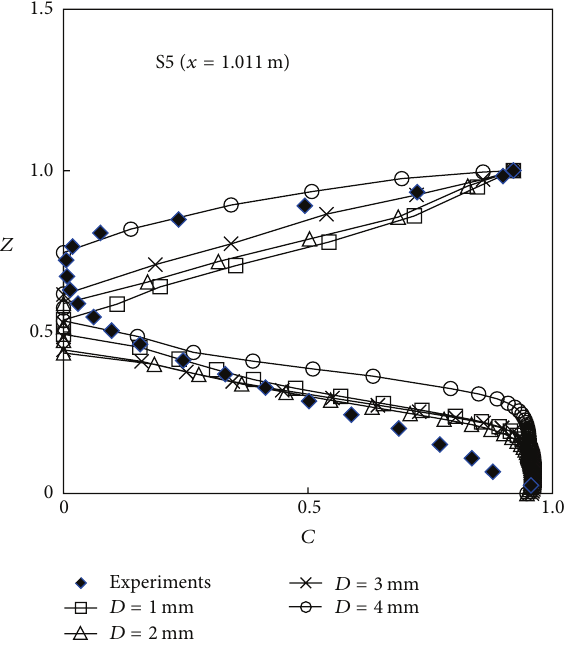
Figure 9: 𝐶 distribution at S5.